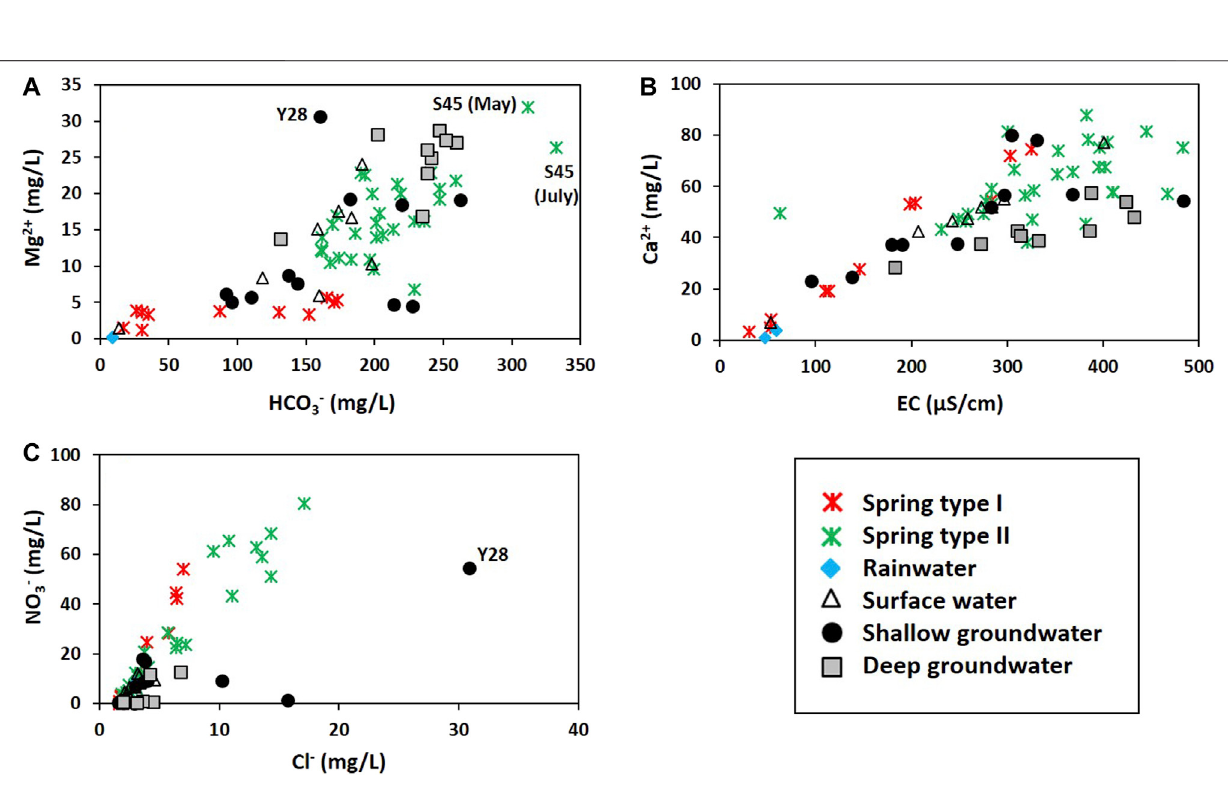
Frontiers in Earth Science |